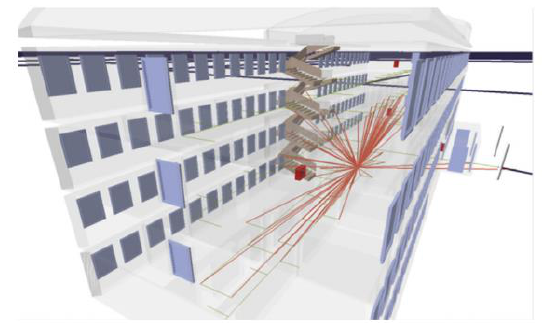
Figure 5. Identifying reachable areas using certain length fire hose (Tashakkori et al.,